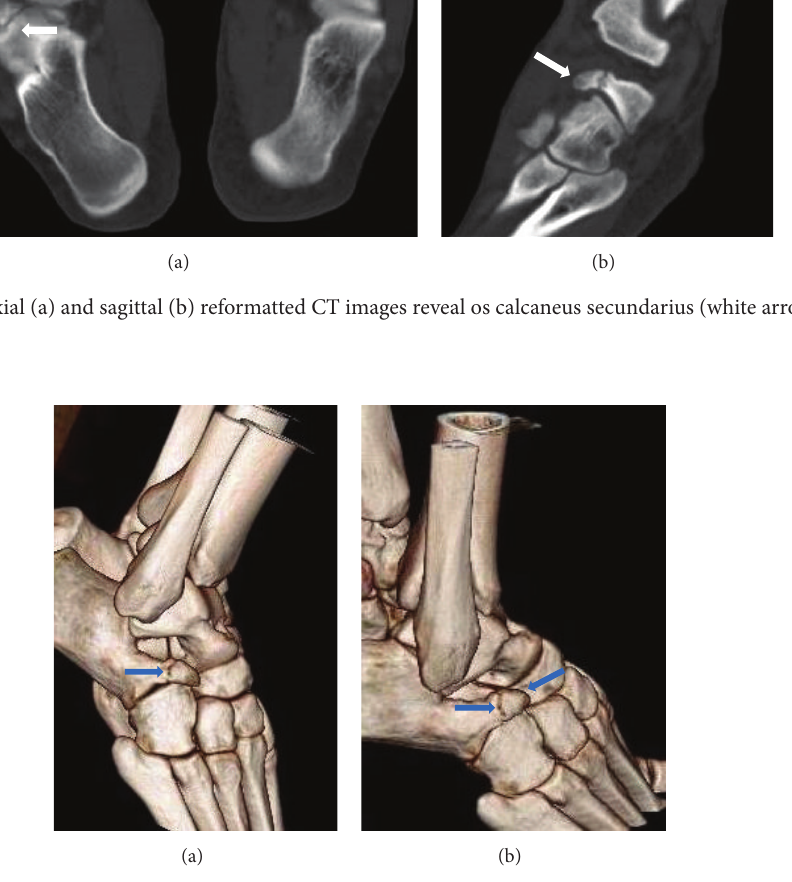
Figure 3: 3D volume rendering CT images (a and b) demonstrate os calcaneus secundarius (blue